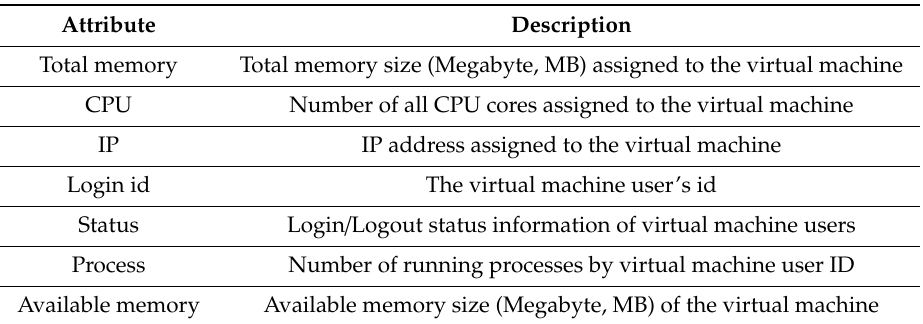
Table 2. Metadata of Idle Virtual Machines for